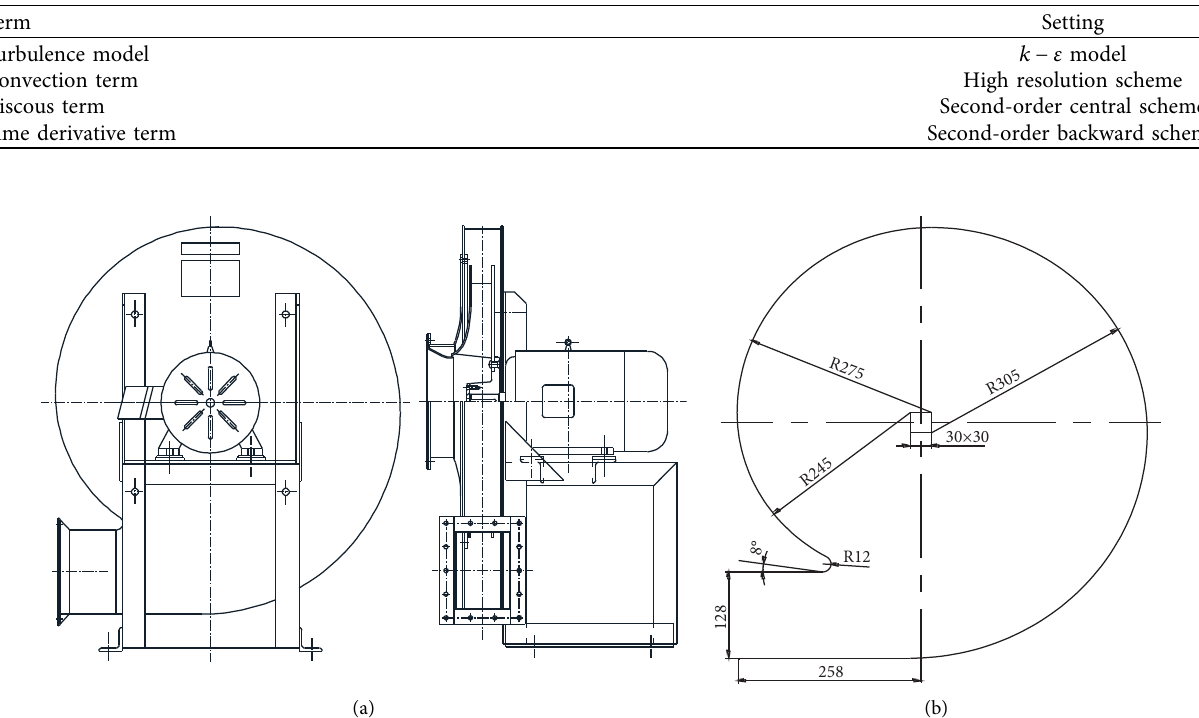
Figure 4: Centrifugal fan structure: (a) overall structure and (b) volute structure.